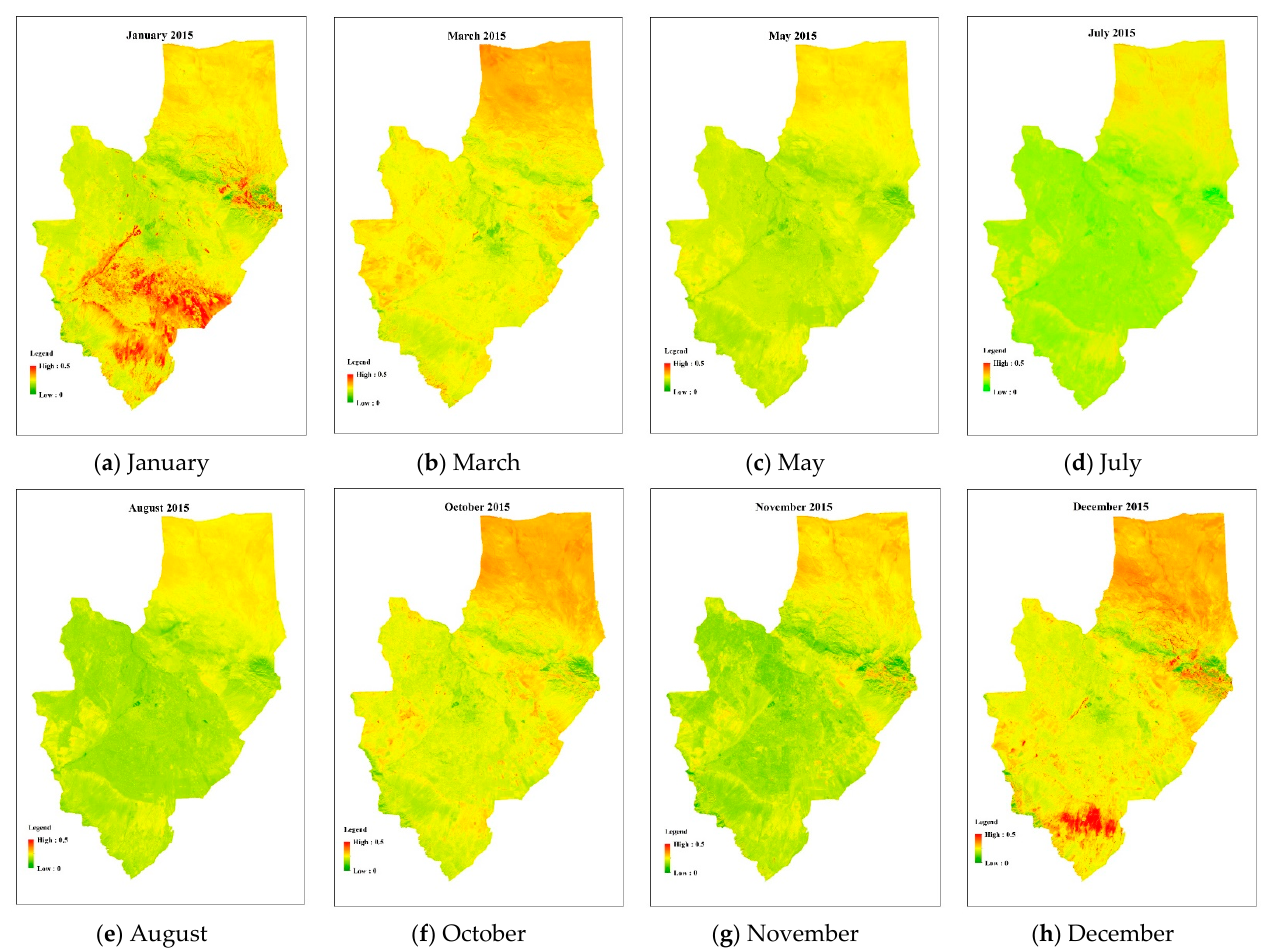
Figure 9. Spatial distribution of surface albedo in Ganzhou in